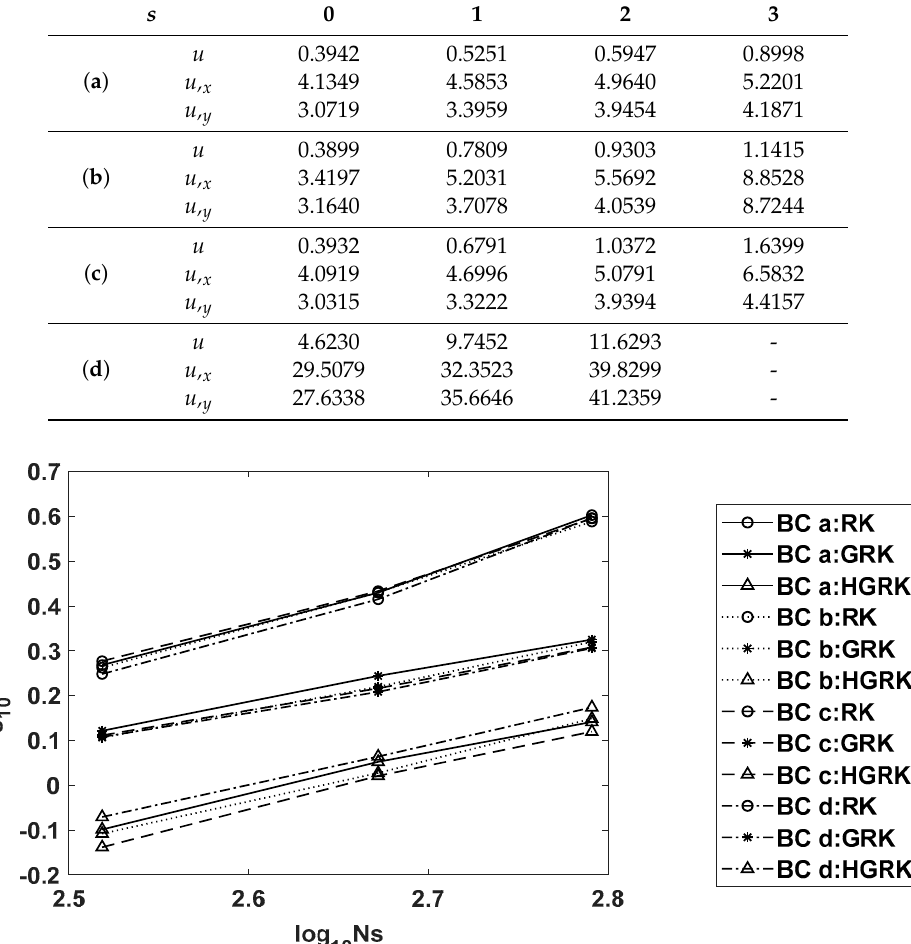
Figure 14. Comparison of CPU time by different methods in the multiply connected domains: type one.